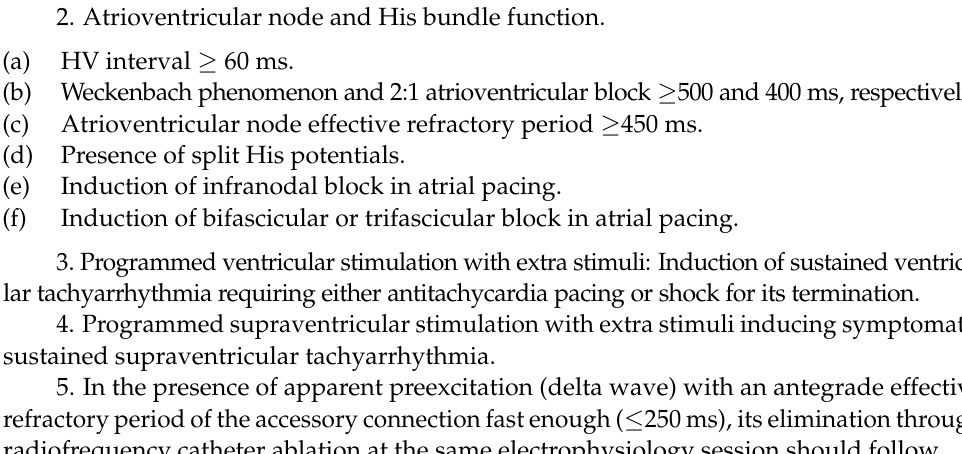
Figure 1. The steps of the diagnostic approach in patients with unexplained syncope.